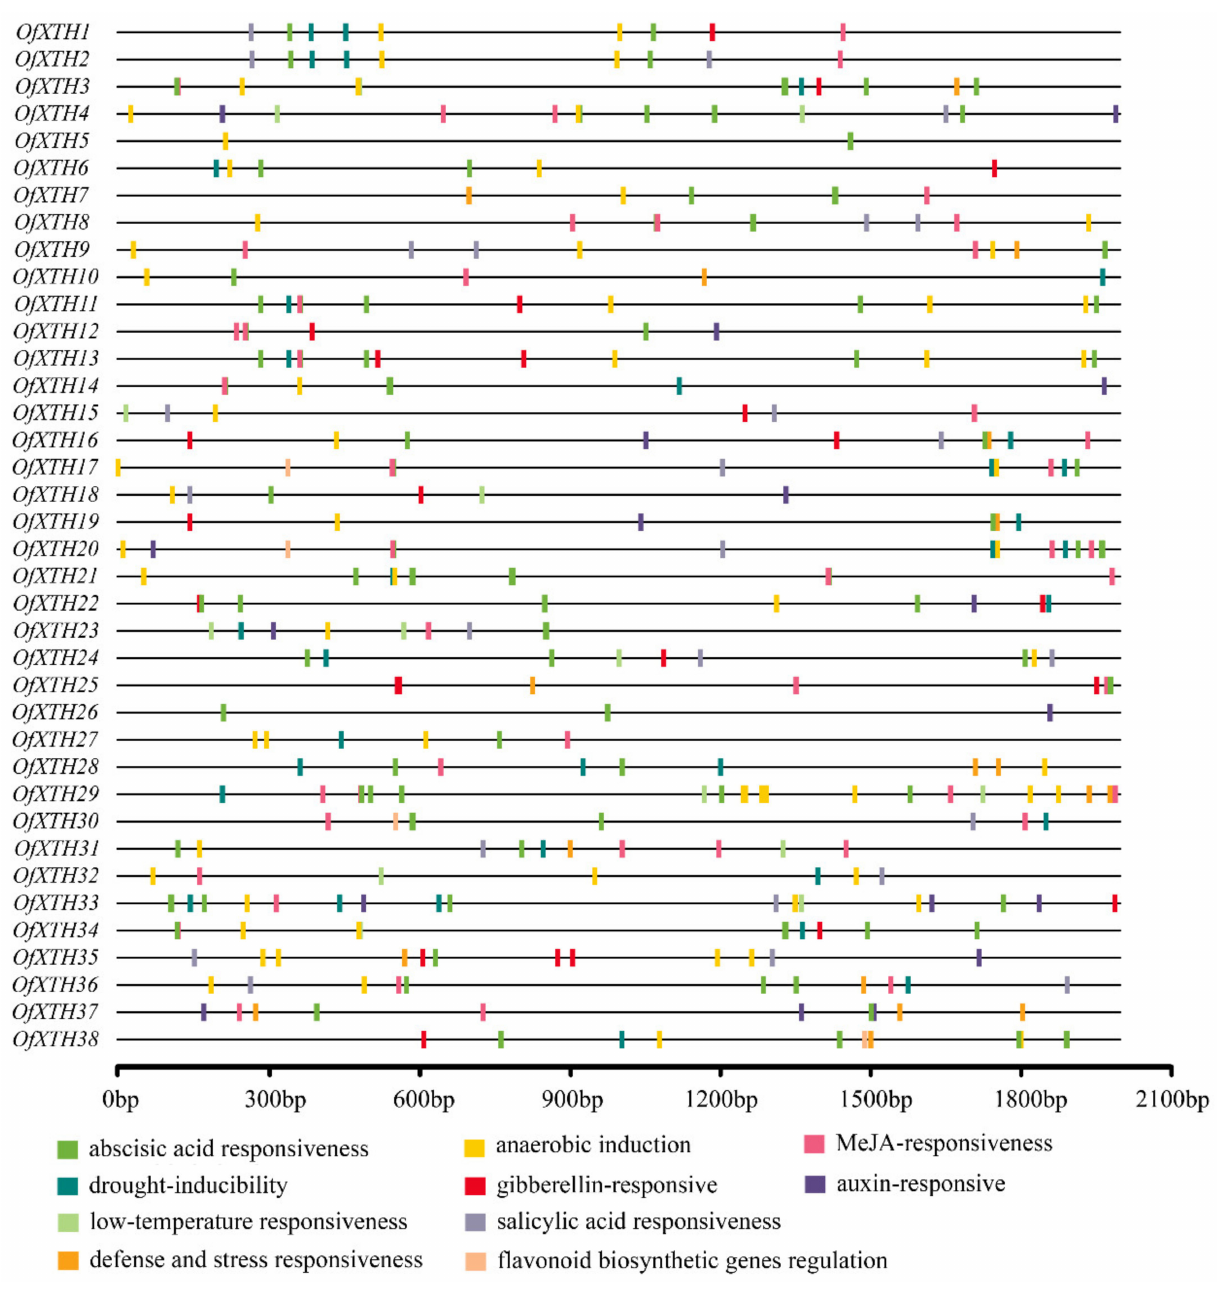
Figure 5. Prediction of cis-responsive elements in the OfXTH promoters. Different cis-responsive elements are represented by different colored